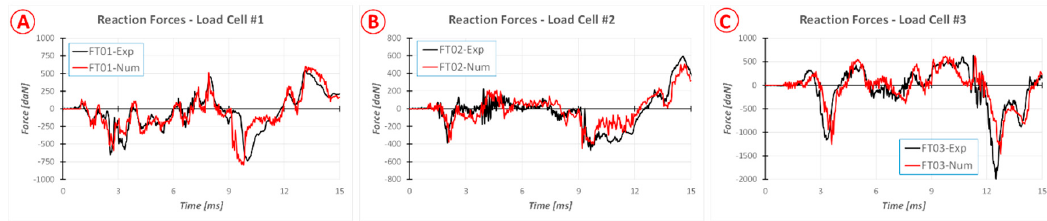
Figure 5. Reaction loads comparison. ( A ) Load cell 01; ( B ) load cell 02; ( C ) load cell 03.